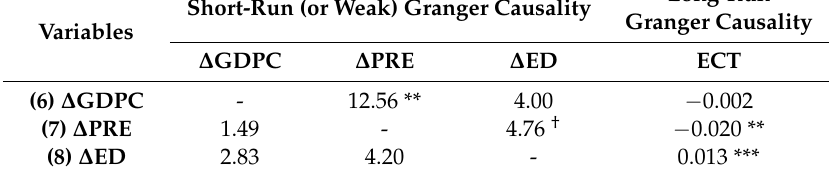
Table 13. Granger causality based on panel vector error correction model (PVECM). Short-Run (or Weak) Granger Variables